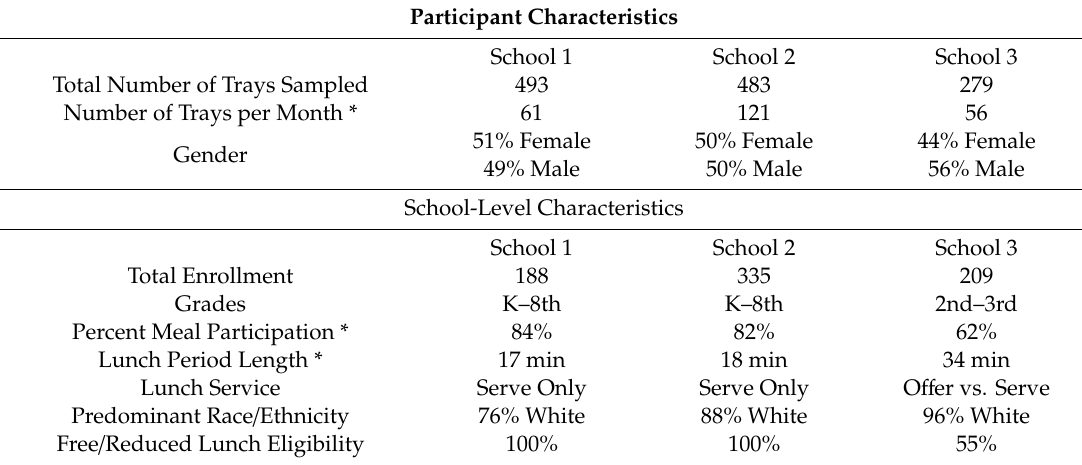
Table 1. Demographic characteristics of intervention schools ( n = 3) and plate waste data participants.